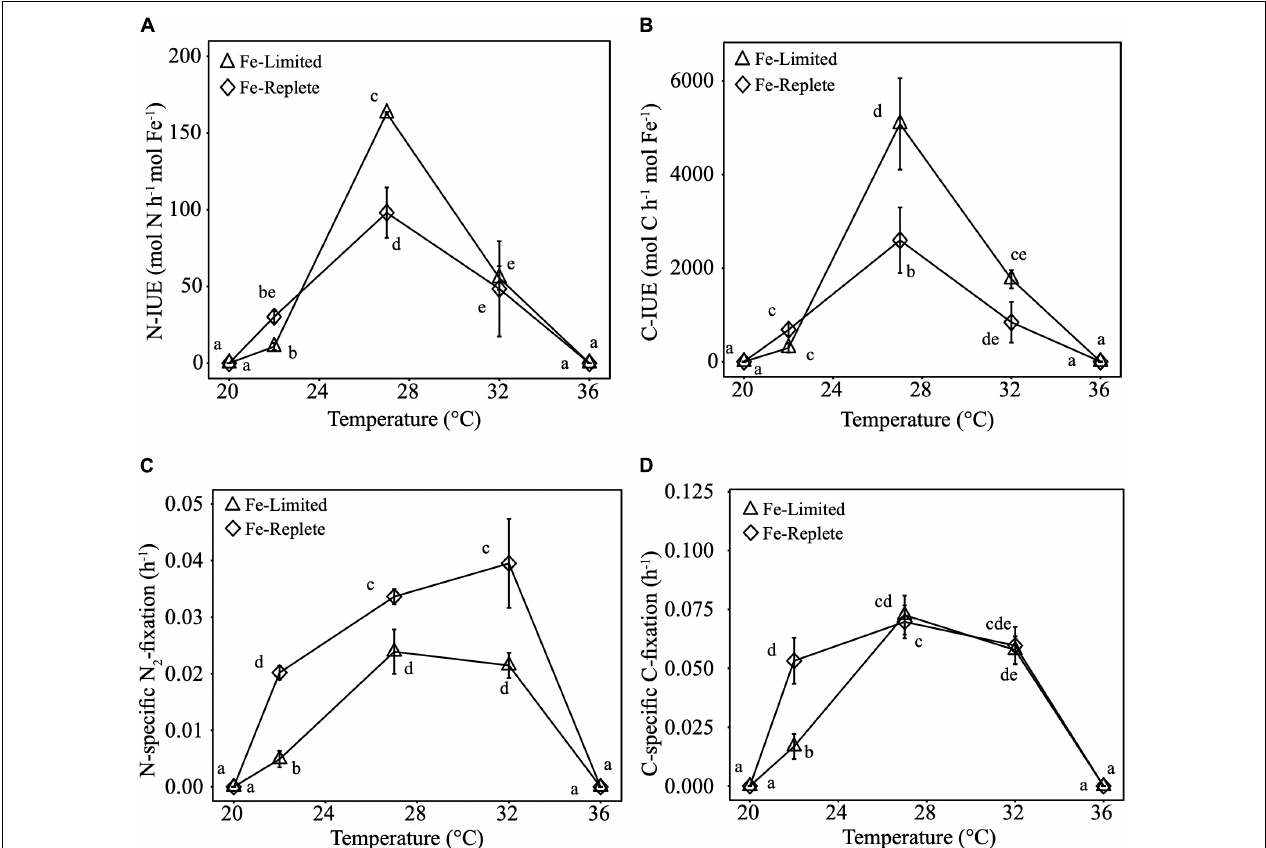
FIGURE 2 | Nitrogen-specific Iron Use Efficiencies (N-IUEs, mols of N fixed h − 1 mol intracellular Fe − 1 ) (A) , Carbon-specific Iron Use Efficiencies (C-IUEs, mols of C fixed h − 1 mol intracellular Fe − 1 ) (B) , Nitrogen-specific nitrogen fixation rates (h − 1 ) (C) , and Carbon-specific carbon fixation rates (h − 1 ) (D) of Crocosphaera grown in triplicate under Replete and Limited iron conditions at 20, 22, 27, 32, and 36 ◦ C. Error bars are standard deviations from the mean and different letters represent statistical significance between mean values at p -value < 0.05.